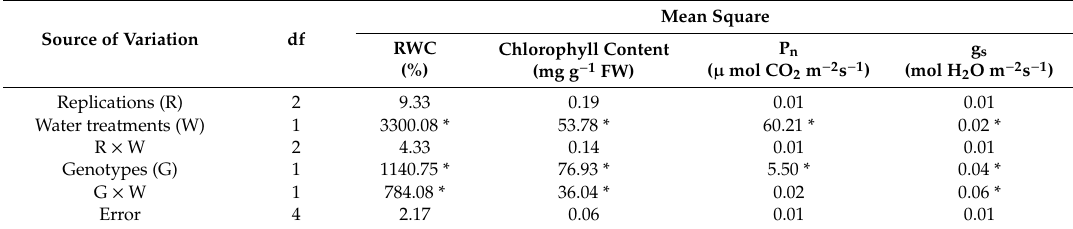
Table 4. Analysis of variance for physiological traits.